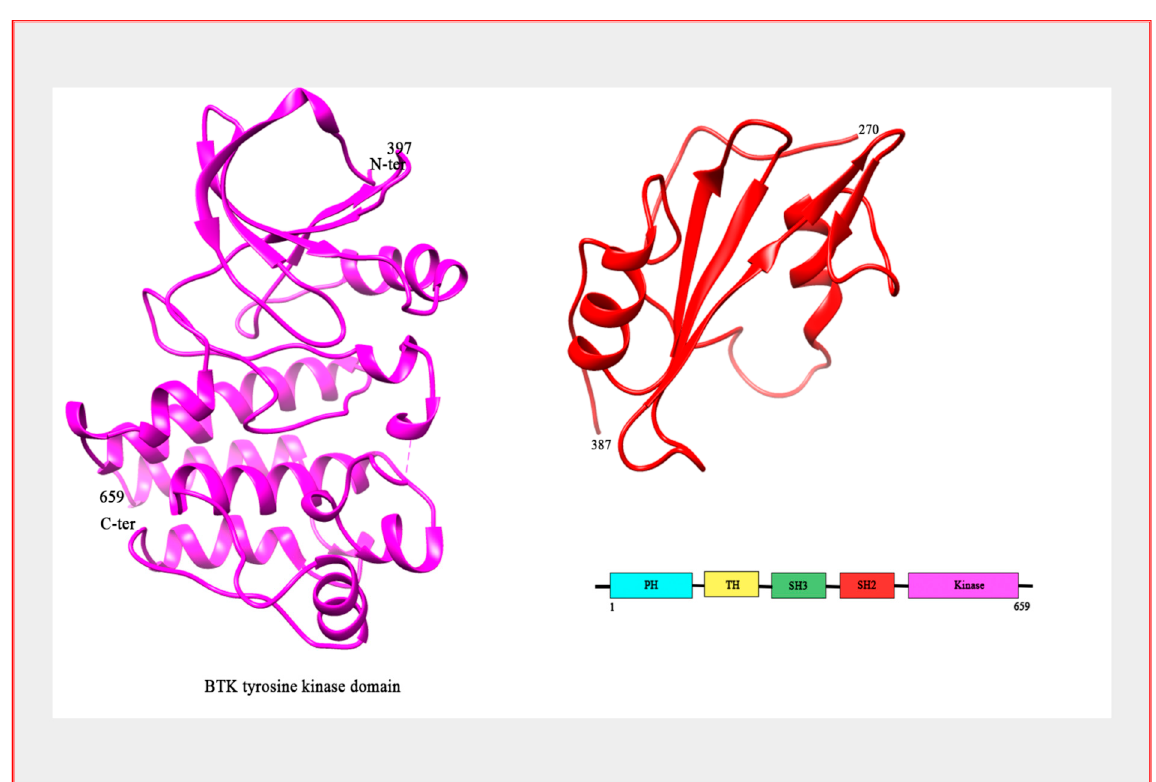
Figure 1. Structure of BTK. The crystal structure of BTK kinase domain (colored magenta; PDB: 3GEN) and SH2 domain (colored red; PDB: 2GE9). Bar Diagram representing the domain organization of the BTK protein.